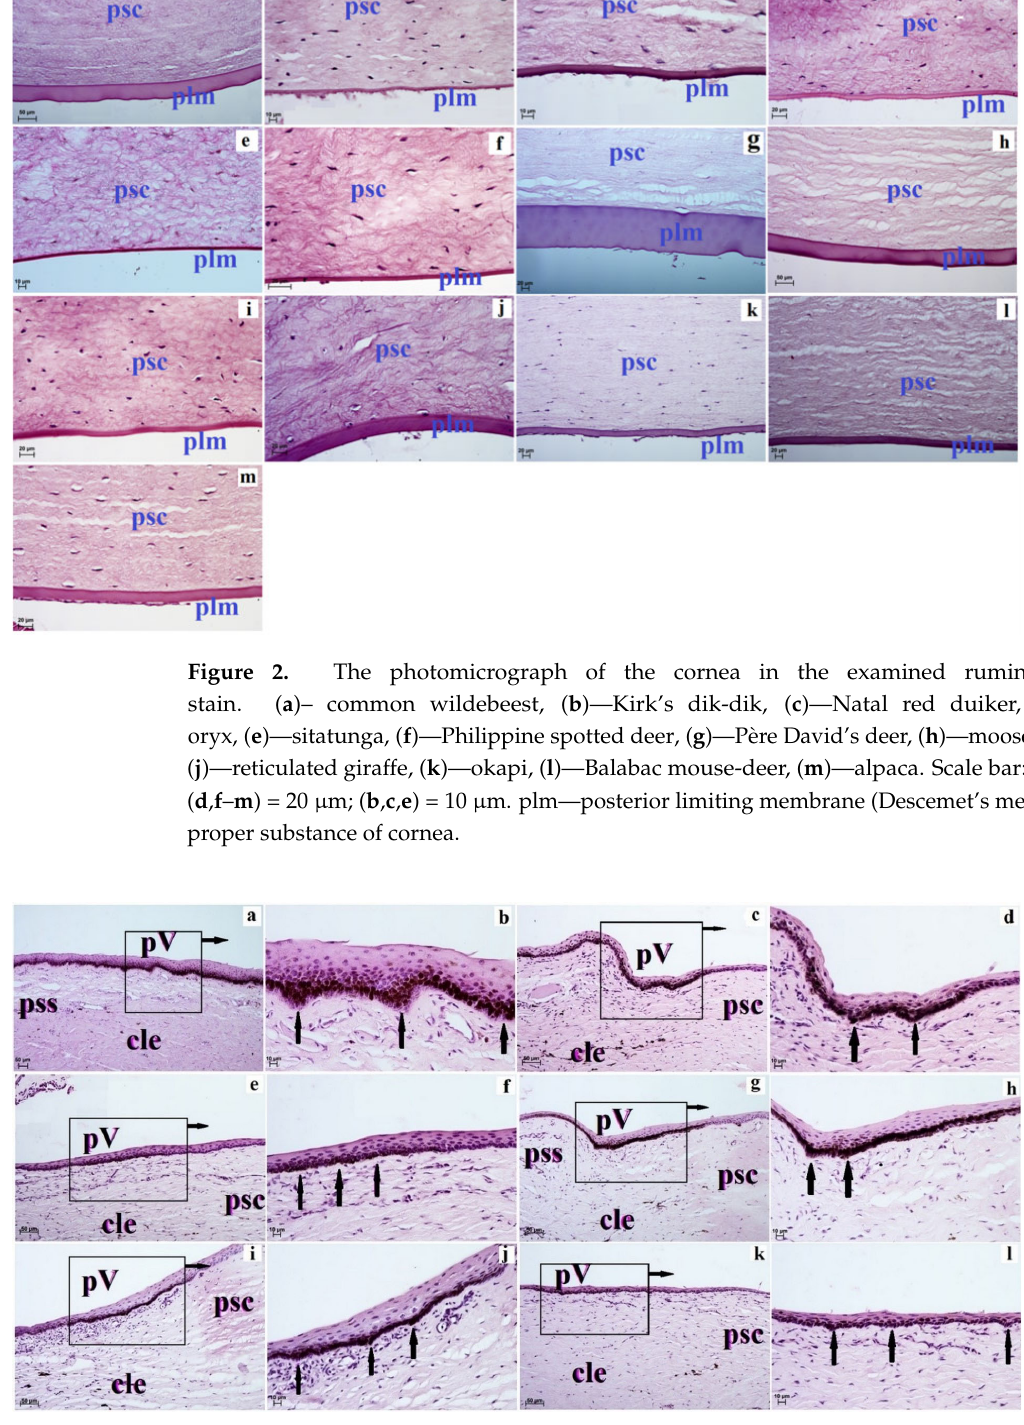
Figure 3. The photomicrograph of the palisades of Vogt in the examined ruminants. H&E stain. ( a , b )—common wildebeest; ( c , d )—Kirk’s dik ‐ dik; ( e , f )—Natal red duiker; ( g , h )—scimitar oryx; ( i , j )—sitatunga; ( k , l )—Philippine spotted deer. Scale bar: ( a , c , e , g , i , k ) = 50 μ m; ( b , d , f , h , j , l ) = 10 μ m. cle—corneal limbus epithelium, psc—the proper substance of the cornea, pss—the proper substance of the sclera, pV—palisades of Vogt (black arrows).